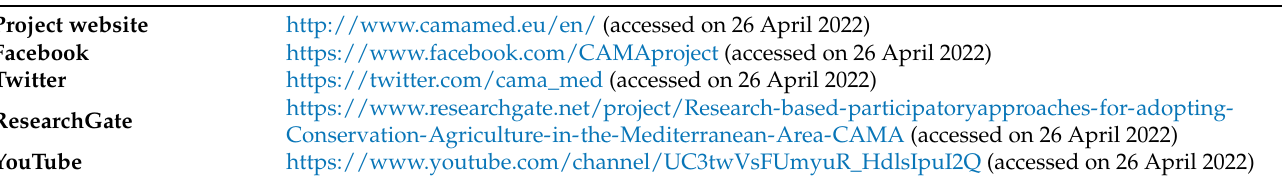
Table 5. CAMA web page and social links .